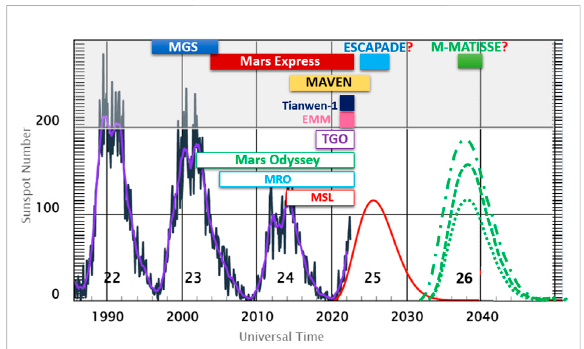
FIGURE 1 Time life of missions at Mars since 1986 with respect to solar cycles 22 – 26. Missions with ionospheric instrumentation are shown with fi lled boxes and over the grey band at the top of the Figure.Missionswithcomplementary atmosphericorparticle observationsareshown with white boxes. ESCAPADE (awaitingfor launch window period) and M-MATISSE (under current ESA study) are also shown as potential future missions. The sunspot numbers are plotted in black and with a running average in purple. The red line shows the current prediction for solar cycle 25. The multiple greenlinesshowsomepotentialpossibilitiesforsolarcycle26with the intention of showing the expected period of maximum solar activity. There has been an active ionospheric mission at Mars since 1996. MGS, Mars Global Surveyor; TGO, ExoMars Trace Gas Orbiter; MSL, Mars Science Laboratory; MRO, Mars Reconnaissance Orbiter; MAVEN, Mars Atmospheric and Volatile EvolutioN; EMM, Emirates Mars Mission; ESCAPADE, The Escape and Plasma Acceleration and Dynamics Explorers; M-MATISSE, Mars Magnetosphere ATmosphere Ionosphere and Space- weather SciencE. This Figure has been modi fi ed from the National Oceanic and Atmospheric Administration (NOAA) Space Weather Prediction Centre (https://www.swpc.noaa.gov/products/solar-